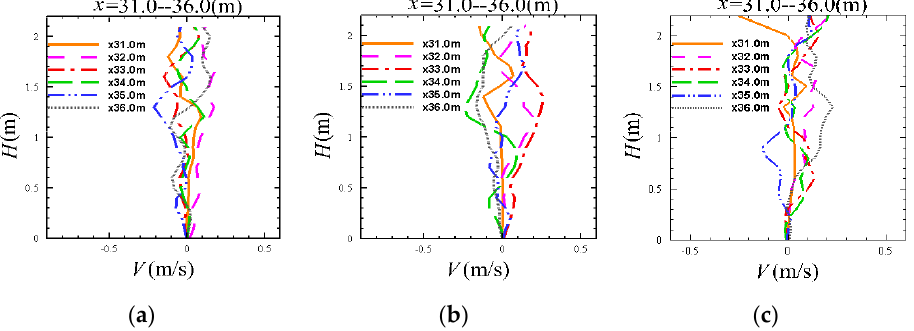
Figure 20. Vertical velocity distribution in the back vortex flow field when the porosity is 0.5, 0.25 and 0.12 and x = 31.0–36.0 m. ( a ) n w = 0.5; ( b ) n w = 0.25; ( c ) n w = 0.125.